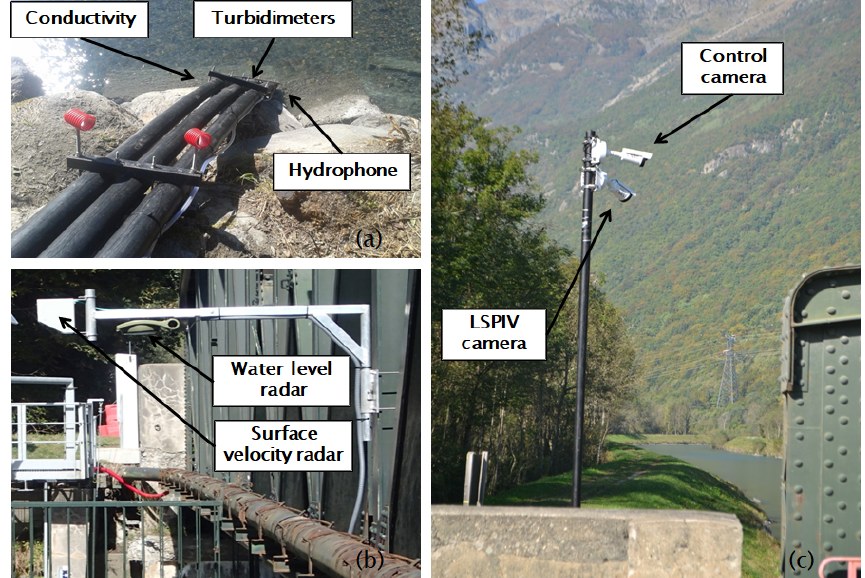
Figure 4. Photos illustrating the deployment of instruments in situ (a) submerged instruments (conductivity probe, turbidimeters and hy- drophone) housed in the polypropylene tubes anchored to the river bank; (b) water level and surface velocity radars supported by extensible brackets fixed to the bridge parapet; (c) control digital camera and LSPIV digital camera fixed at the top of a mast located on the river